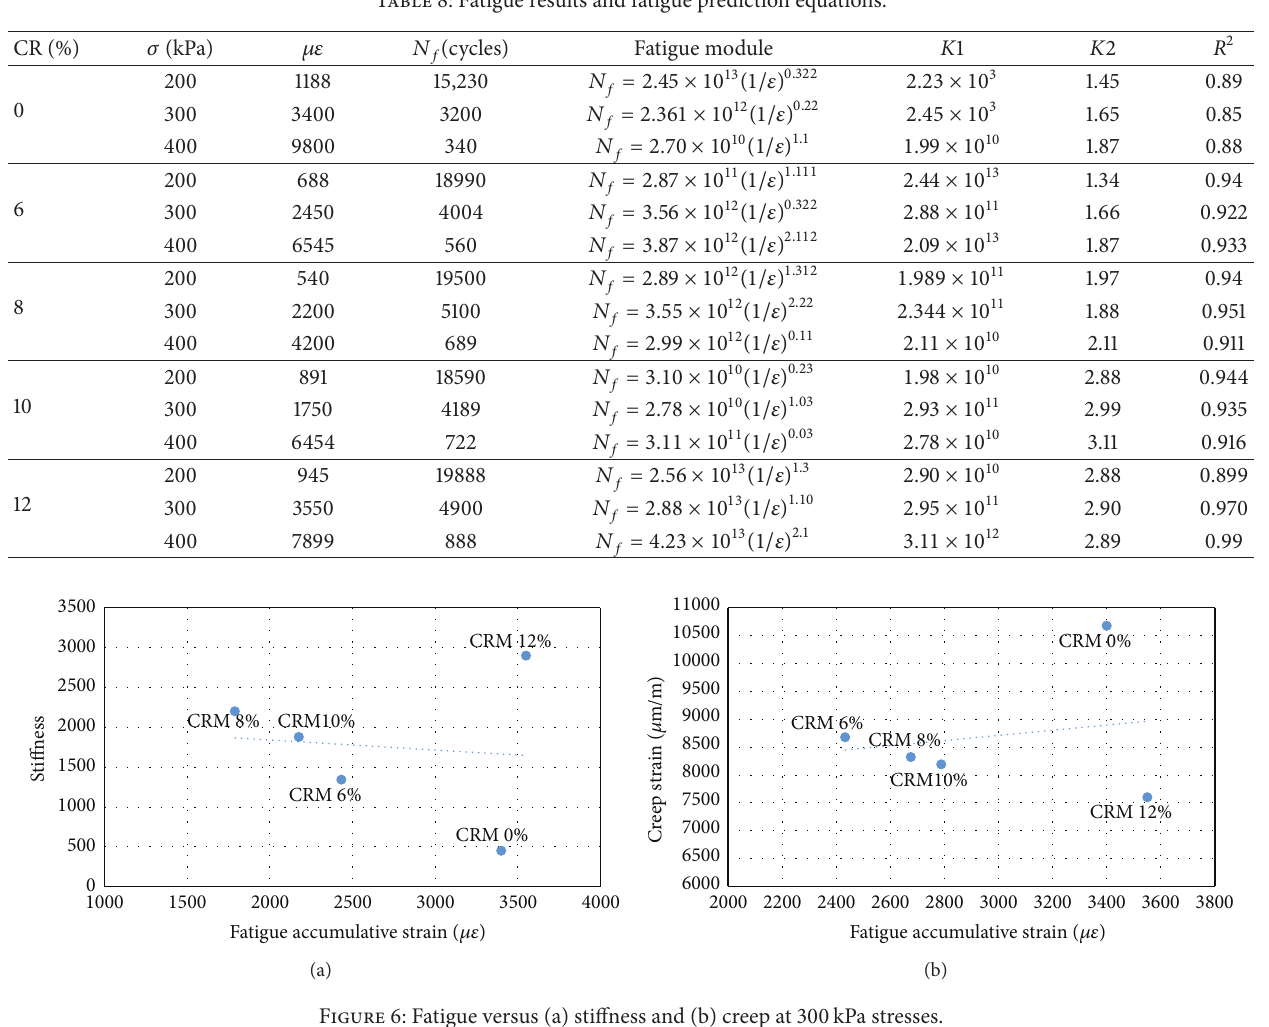
Table 8: Fatigue results and fatigue prediction equations.